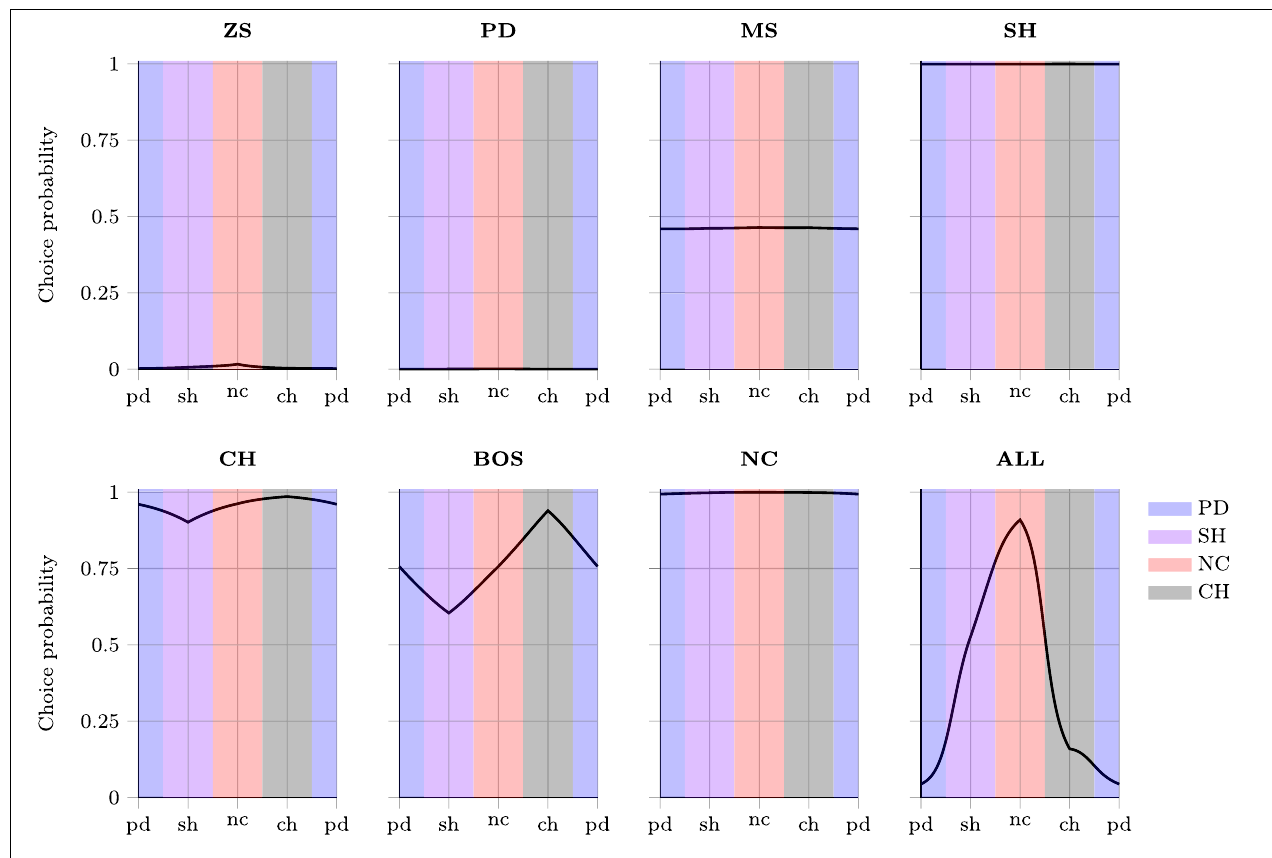
FIGURE 4 | Deep vs. superficial transfer of learning in a sequence of